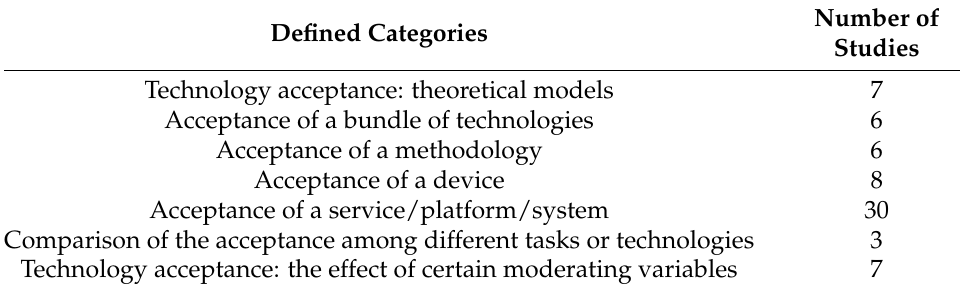
Table 1. Identified research